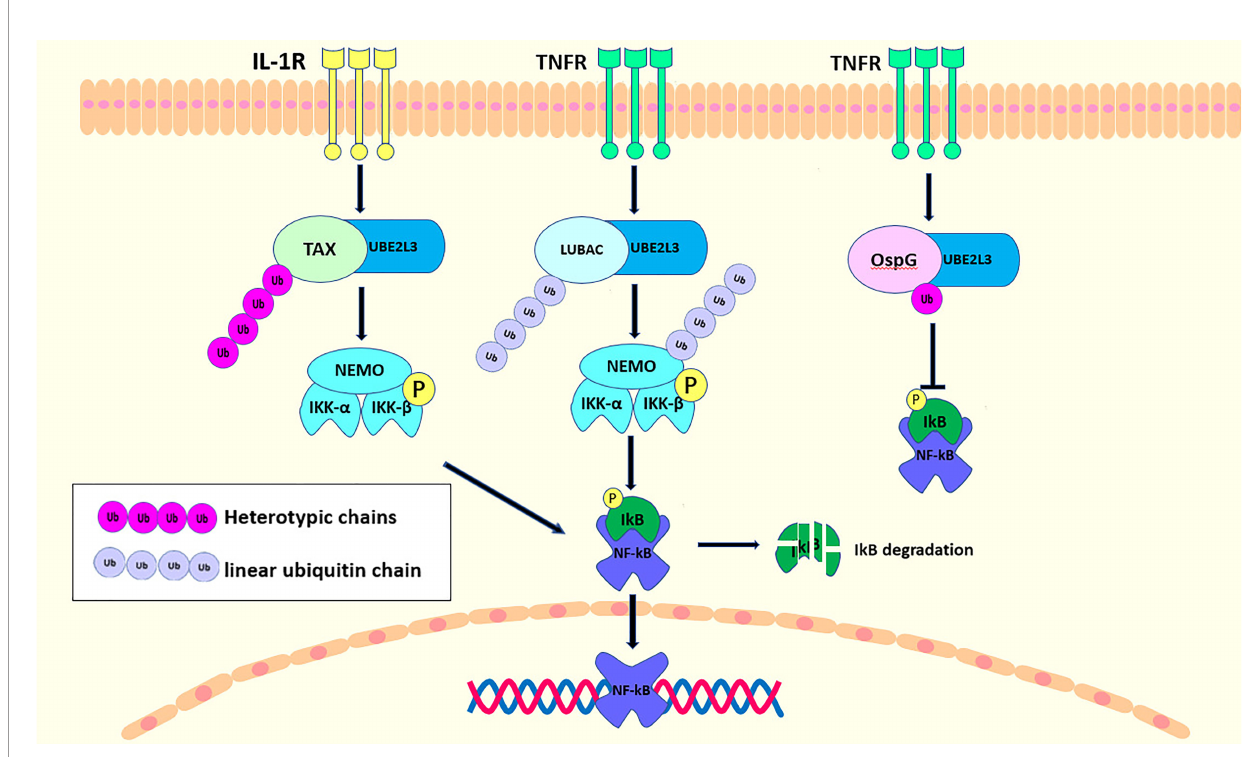
FIGURE 3 | UBE2L3 binding with different E3 ubiquitin ligases acts on NF- k B signaling pathway. Upon the stimulation of IL-1R, TAX interacts with UBE2L3 to synthesize the heterotypic chains, resulting in I k B phosphorylation, and the degradation and activation of NF- k B. In the TNFR pathway, UBE2L3 interacts with LUBAC to synthesize fi rst, a linear ubiquitin chain, then there is a linear ubiquitination of NEMO and a phosphorylation of IKK b , ultimately leading to the activation of NF- k B. While OspG can interact with UBE2L3-Ub conjugates to improve the kinase activity of OspG, which inhibit the activation of NF- k